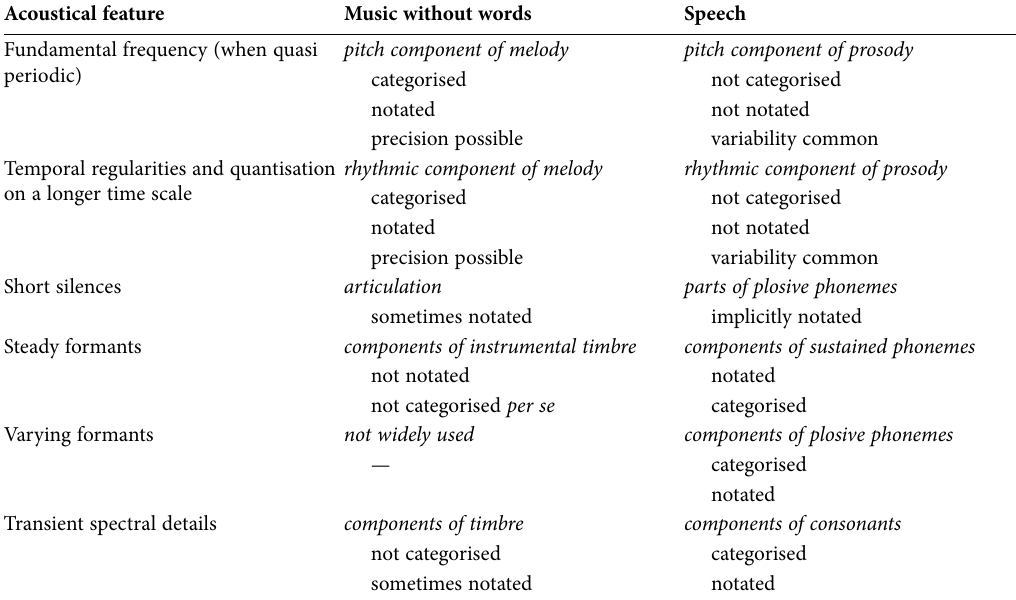
Table 1. Acoustical features of music and speech signals show complementary coding. (Reproduced from